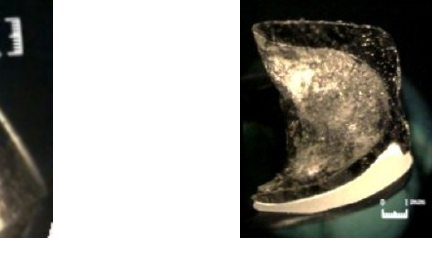
Figure 1. Metal-ceramic crown, detail.